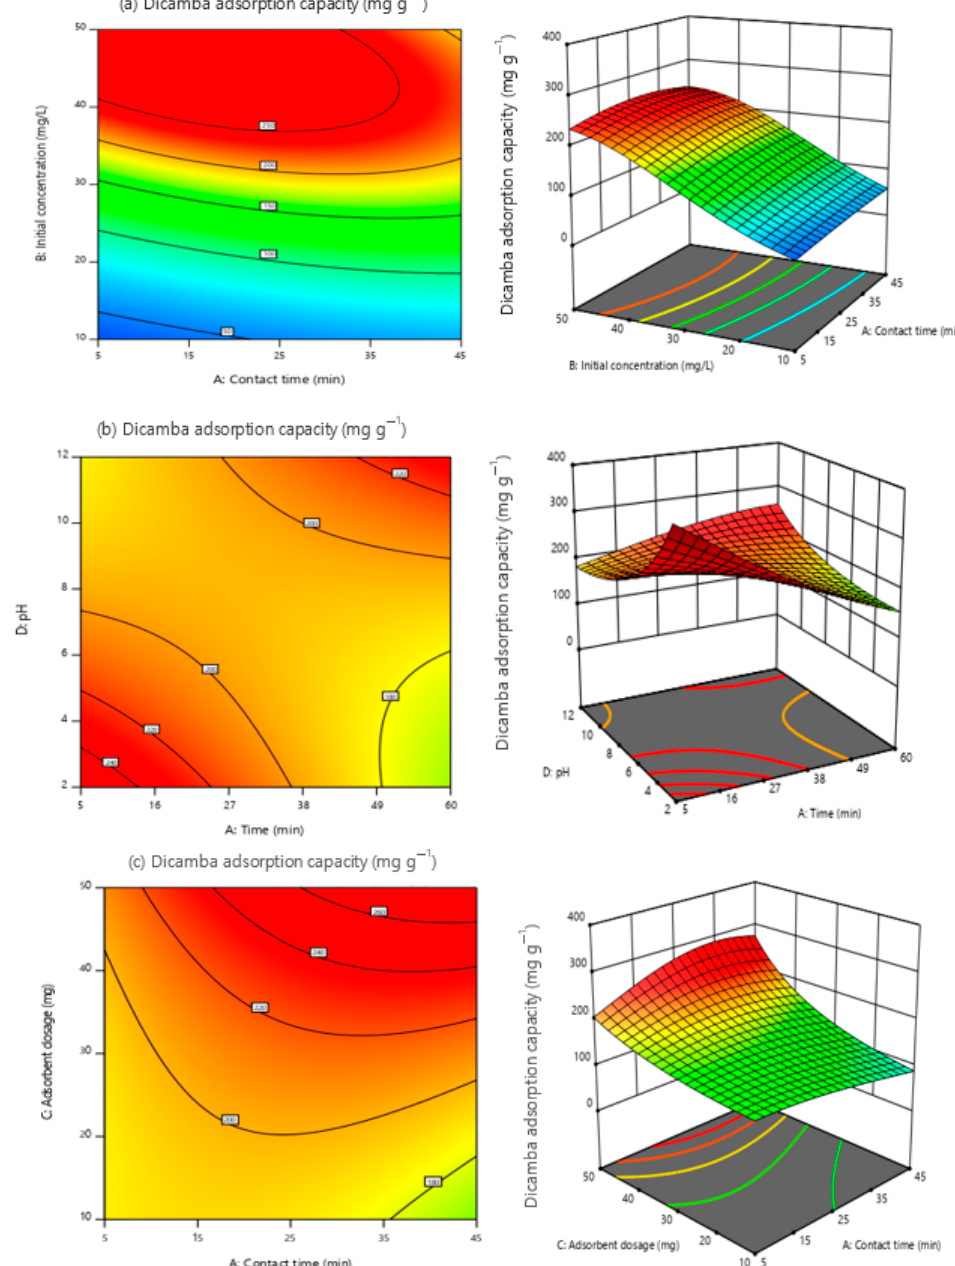
Figure 5. Multivariate interaction for adsorption capacity of dicamba (mg g − 1 ), ( a ) initial dicamba concentration and contact time, ( b ) solution pH and contact time ( c ) adsorbent dosage and contact time.